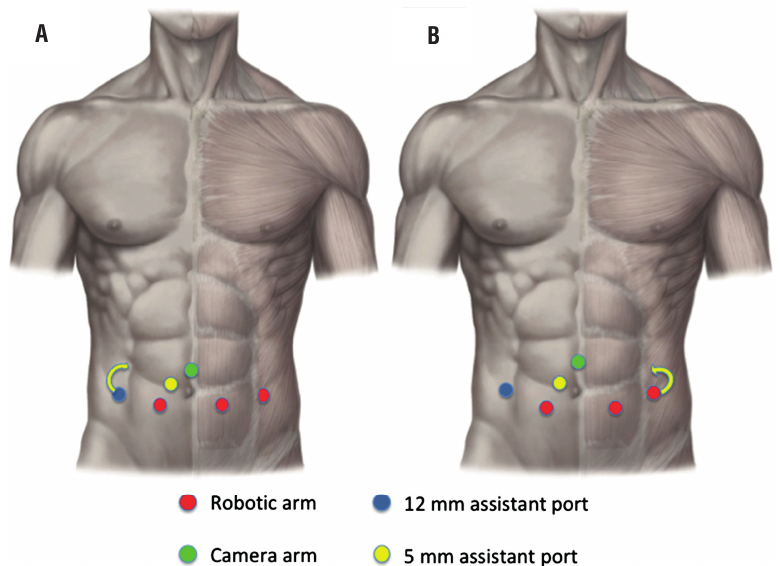
Figure 1 - Robotic and assistant port positioning for T-RARP.